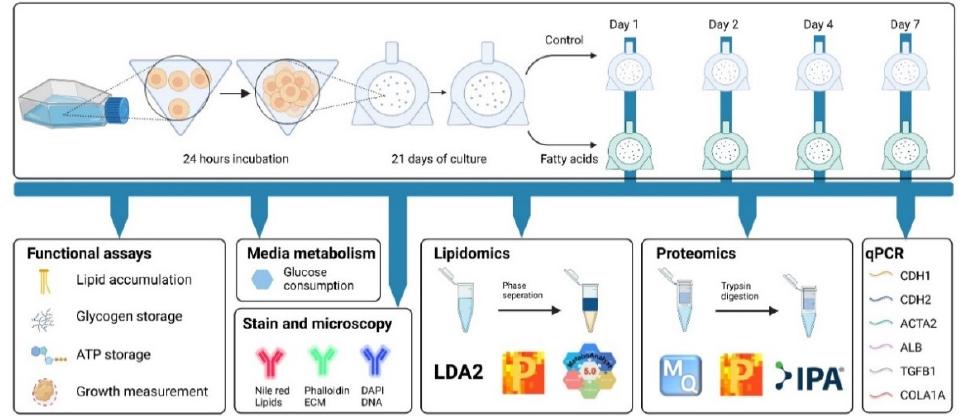
Figure 1. Experiment overview. Top panel—Creating and exposing HepG2/C3A spheroids to fatty acids (FA) (45 μM palmitic acid and 65 μM oleic acid conjugated to BSA). Cells are seeded into low attachment microwell plates. After 24 h, mini spheroids are transferred into rotary bioreactors and cultured for 21 days before exposure to FA. Samples are harvested after 0, 1, 2, 4 and 7 days of FA treatment. Bottom panel—measurements and tests performed in this study (see methods section).